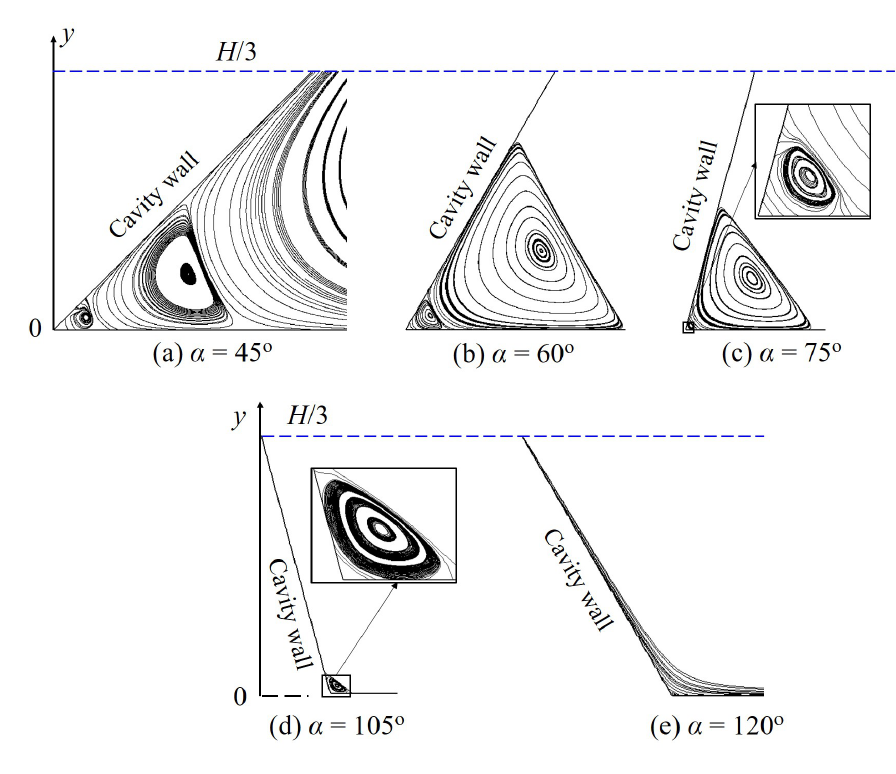
Figure 16. Vortex structures at the left corner produced by the polymer flow in the skewed cavities with different α at Od = 1